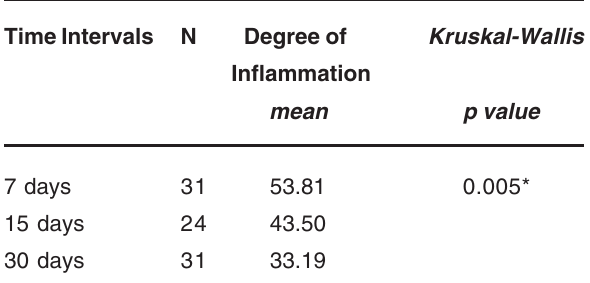
TABLE 3- Mean position of time intervals in relation to the degree of inflammation